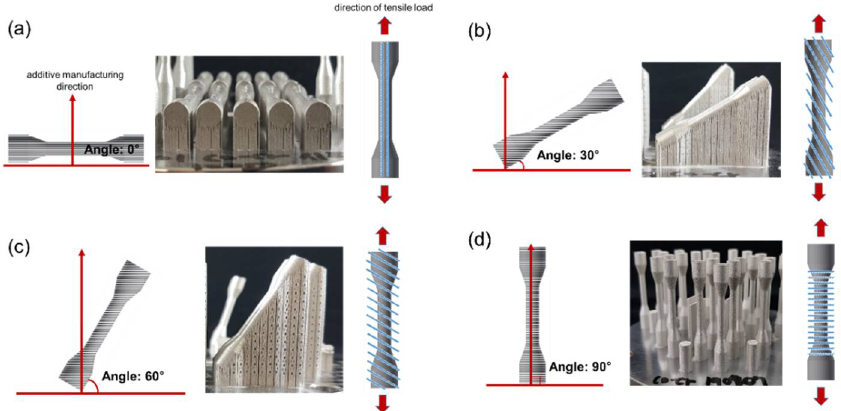
Figure 3. The additive manufacturing direction and the direction of tensile load: ( a ) 0°; ( b ) 30°; ( c ) 60°; ( d ) 90°.